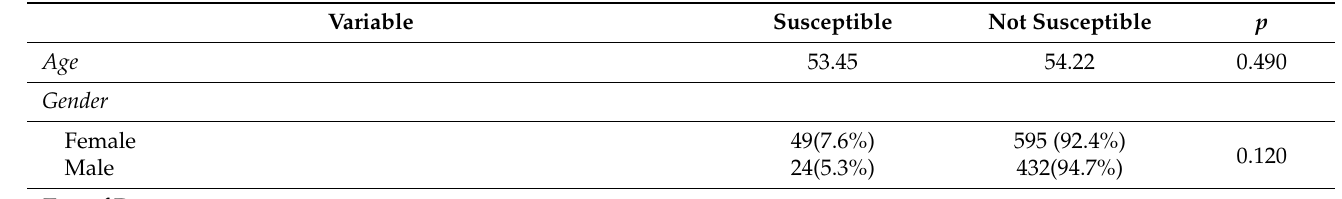
Table 2. Univariate analysis relating to rubella